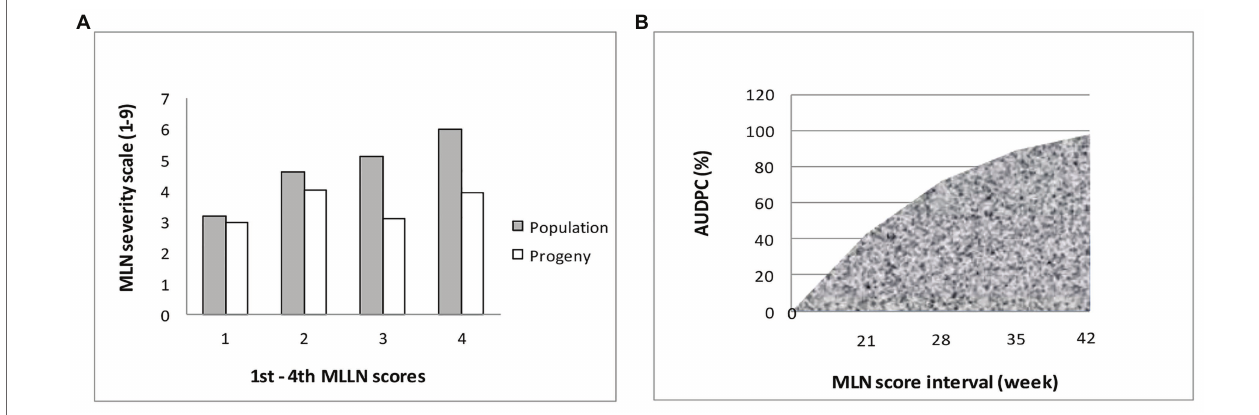
FIGURE 4 | (A) Means of best BC 3 F 2 progeny compared to population means across four scores; (B) Area under disease progress curve (AUDPC) produced by plotting AUDPC values (along y-axis) against MLN development stage (along